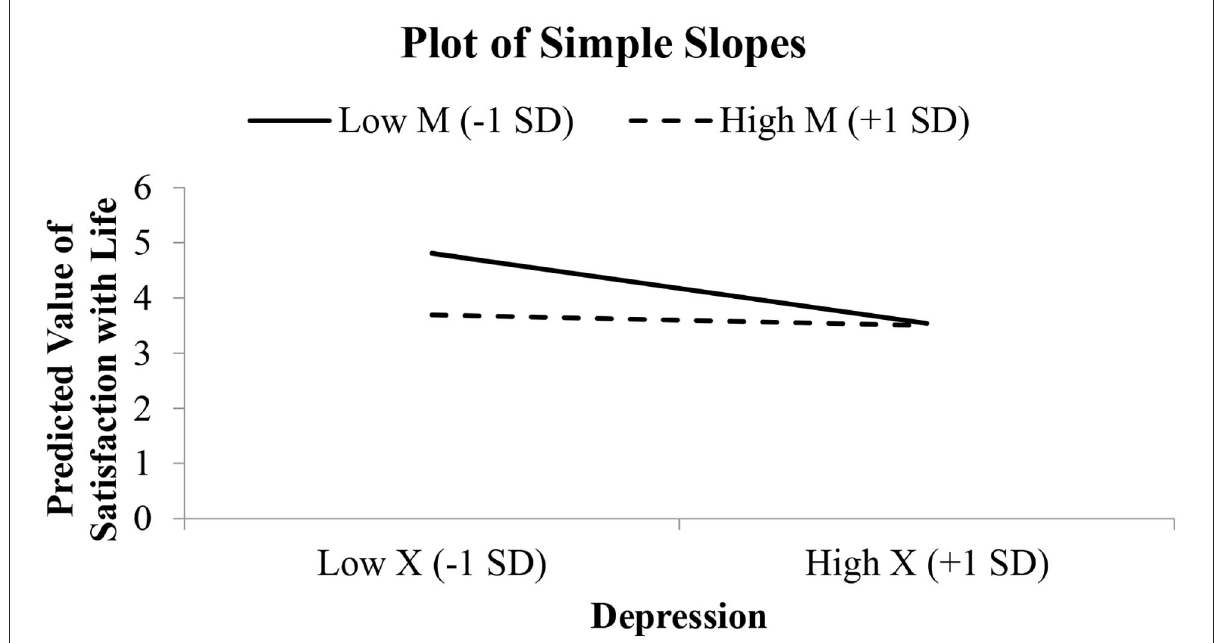
FIGURE3 Simple slope graph for the model relating satisfaction with life to depression, perceived burdensomeness, and their